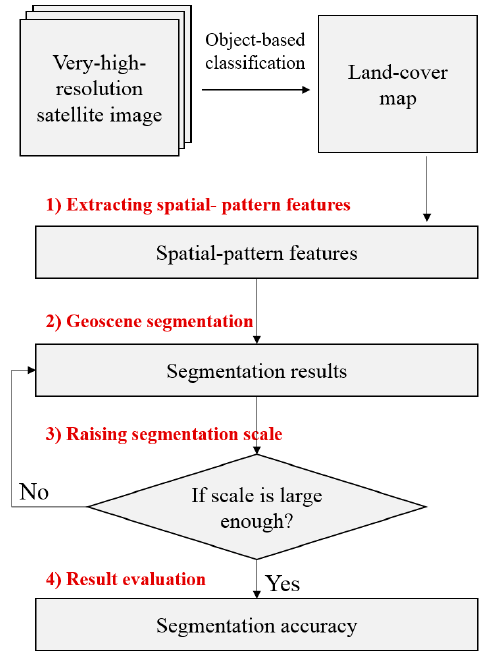
Figure 4. Framework of multiscale geoscene segmentation.